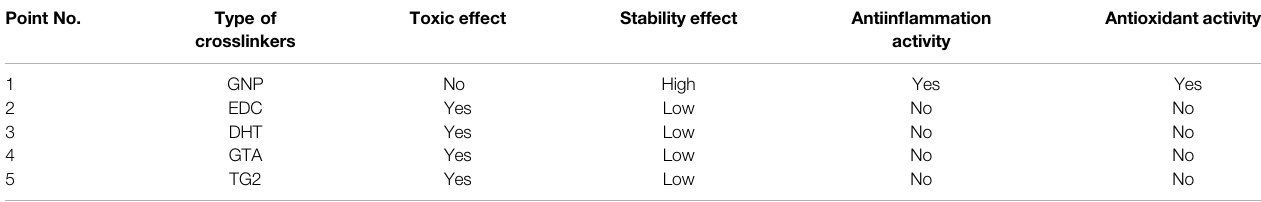
TABLE 1 | Comparison between GNP and other crosslinking methods. Point